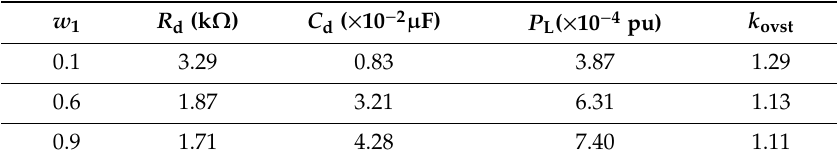
Table 6. E ff ects of w 1 on Optimization Results.